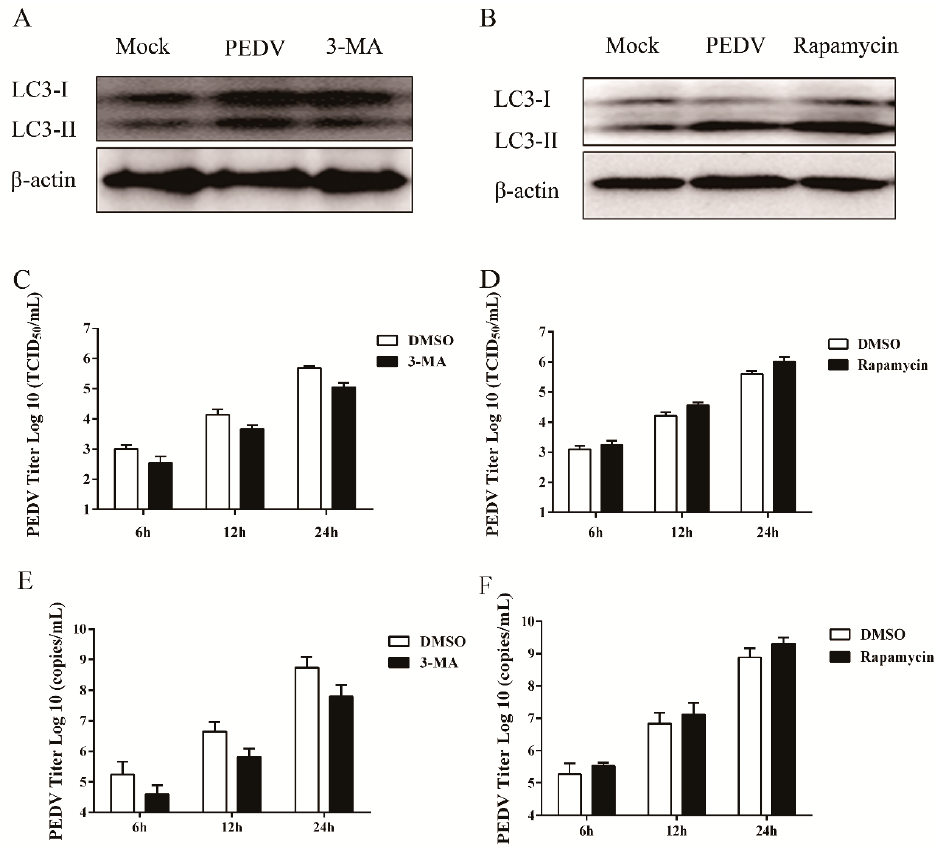
Figure 4. Pharmacological inhibition of autophagy decreases viral yield. ( A , B ) Vero cells were pretreated separately with 3-MA (5 mM) ( A ) or rapamycin (1 µ g/mL) ( C ) for 4 h prior to PEDV (0.1 MOI) infection. After PEDV adsorption for 1 h, the cells were further cultured in fresh medium in the absence or presence of 3-MA or rapamycin. DMSO was used as a control. At 24 hpi, cell samples were detected by Western blot with antibodies against LC3 and β -actin. ( C , D ) The cells were collected separately at 6, 12, and 24 hpi to determine the viral titer. The data were presented as mean ± SEM of three independent experiments. ( E , F ) The cells were collected separately at 6, 12, and 24 hpi. The virus copy number was determined by real time PCR. The data were presented as mean ± SEM of three independent